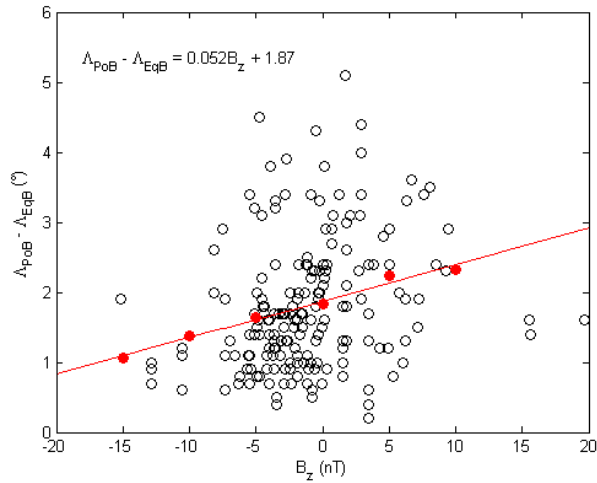
Fig. 6. Cusp latitudinal width as a function of IMF- B z . Red dots show average widths binned by IMF B z